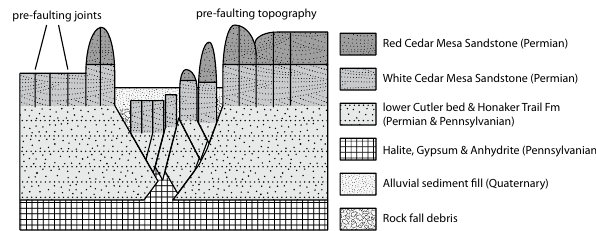
Figure 19. Schematic model of a typical Canyonlands graben from the northern section. Joints of the Cedar Mesa sandstones are reac- tivated by faulting. Shallower fault dips at depth cause open gaps at surface and secondary faulting within the grabens. Rockfall debris and alluvial sediments fill up open gaps and graben